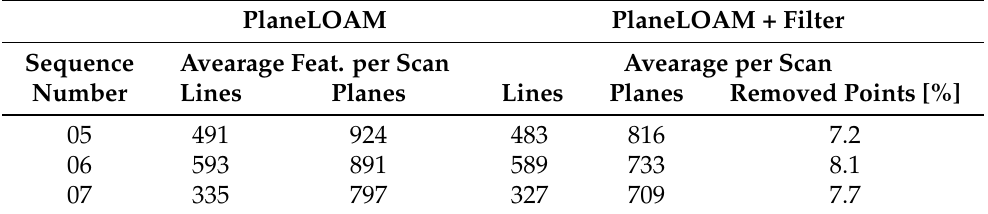
Figure 13. The trajectories estimated by PlaneLOAM with a learned filter for non-stationary objects obtained from the KITTI sequences used in evaluation: 05 ( A ), 06 ( B ) and 07 ( C ). In ( B , C ) the red error lines are almost invisible due to the highly accurate trajectory estimation. Table 2. Statistics of the LiDAR points and PlaneLOAM features for three KITTI sequences used in